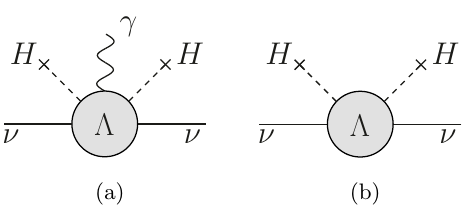
Figure 1 . Feynman diagrams generating the NMM and the radiative neutrino mass for Majorana neutrinos induced by new physics above the electroweak scale.